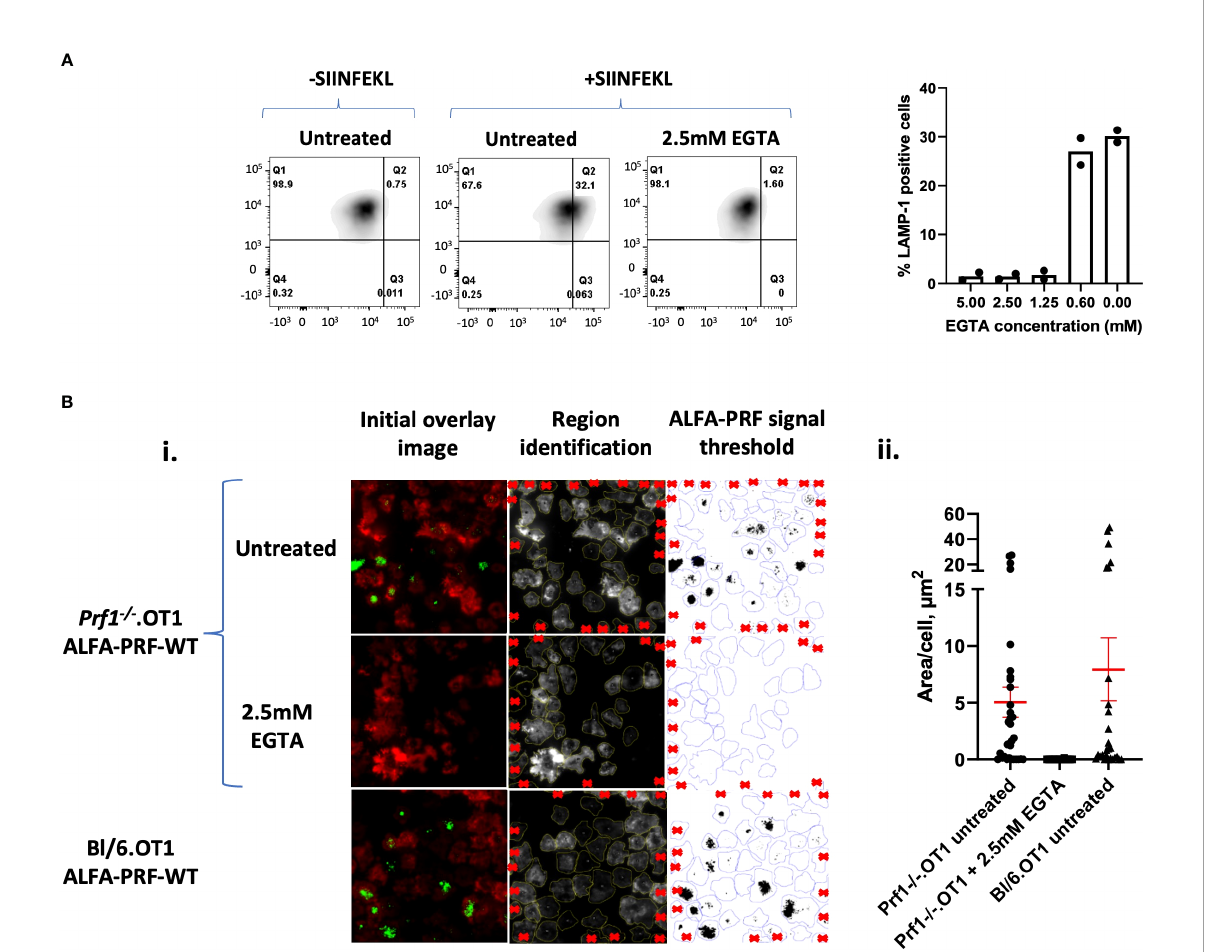
FIGURE 4 Quanti fi cation of ALFA-PRF-WT released into the synapse. (A) Degranulation assay (detecting LAMP-1 externalisation) shows inhibition of degranulation at 2.5 mM EGTA. Individual values are shown in Supplementary Table 3. N=2 biological replicates (mice). (B) (i) First column: TIRF microscopy images of Prf1 -/- .OT1 cells expressing Lifeact-mScarlet (Red) and ALFA-PRF-WT (Top and middle rows) or Bl/6.OT1 expressing Lifeact-mScarlet (Red) and ALFA-PRF-WT (bottom row) after 45 minutes incubation on an anti-CD3/CD28 coated surface to induce synapse formation. ALFA-PRF-WT expressing Prf1 -/- .OT1 cells were untreated or treated with EGTA. ALFA-PRF-WT is detected by FluoTag ® -X2 anti- ALFA Atto 488 nanobodies (green). Second column: Lifeact-mScarlet and ALFA-PRF-WT channels were separated, regions drawn around the cells (Lifeact-mScarlet signal) and cells on edge regions noted for exclusion (red crosses). Third column: Regions were then transferred to the ALFA-PRF-WT channel and the signal thresholded to the maximum grey value within cell regions on the ALFA-PRF-WT channel of the Empty Vector control image (Empty Vector control image is shown in Supplementary fi gure 5). ii.) Thresholded images presented in i.) were analysed ‘ limited to threshold ’ to give values of perforin area per cell region. Mean values ( ± s.e.m. of n cells from one representative experiment) are: Prf1 -/- .OT1 untreated - 5.045 ± 1.332 (n=32); Prf1 -/- .OT1 +2.5mM EGTA - 0.006 ± 0.006 (n=27); Bl/6.OT1 untreated - 7.933 ± 2.772 (n=27). “ n ” refers to individual cells within the fi eld of view, where regions were identi fi ed/excluded as per Figure 5B.i. Individual values are shown in Supplementary Table 4, from one